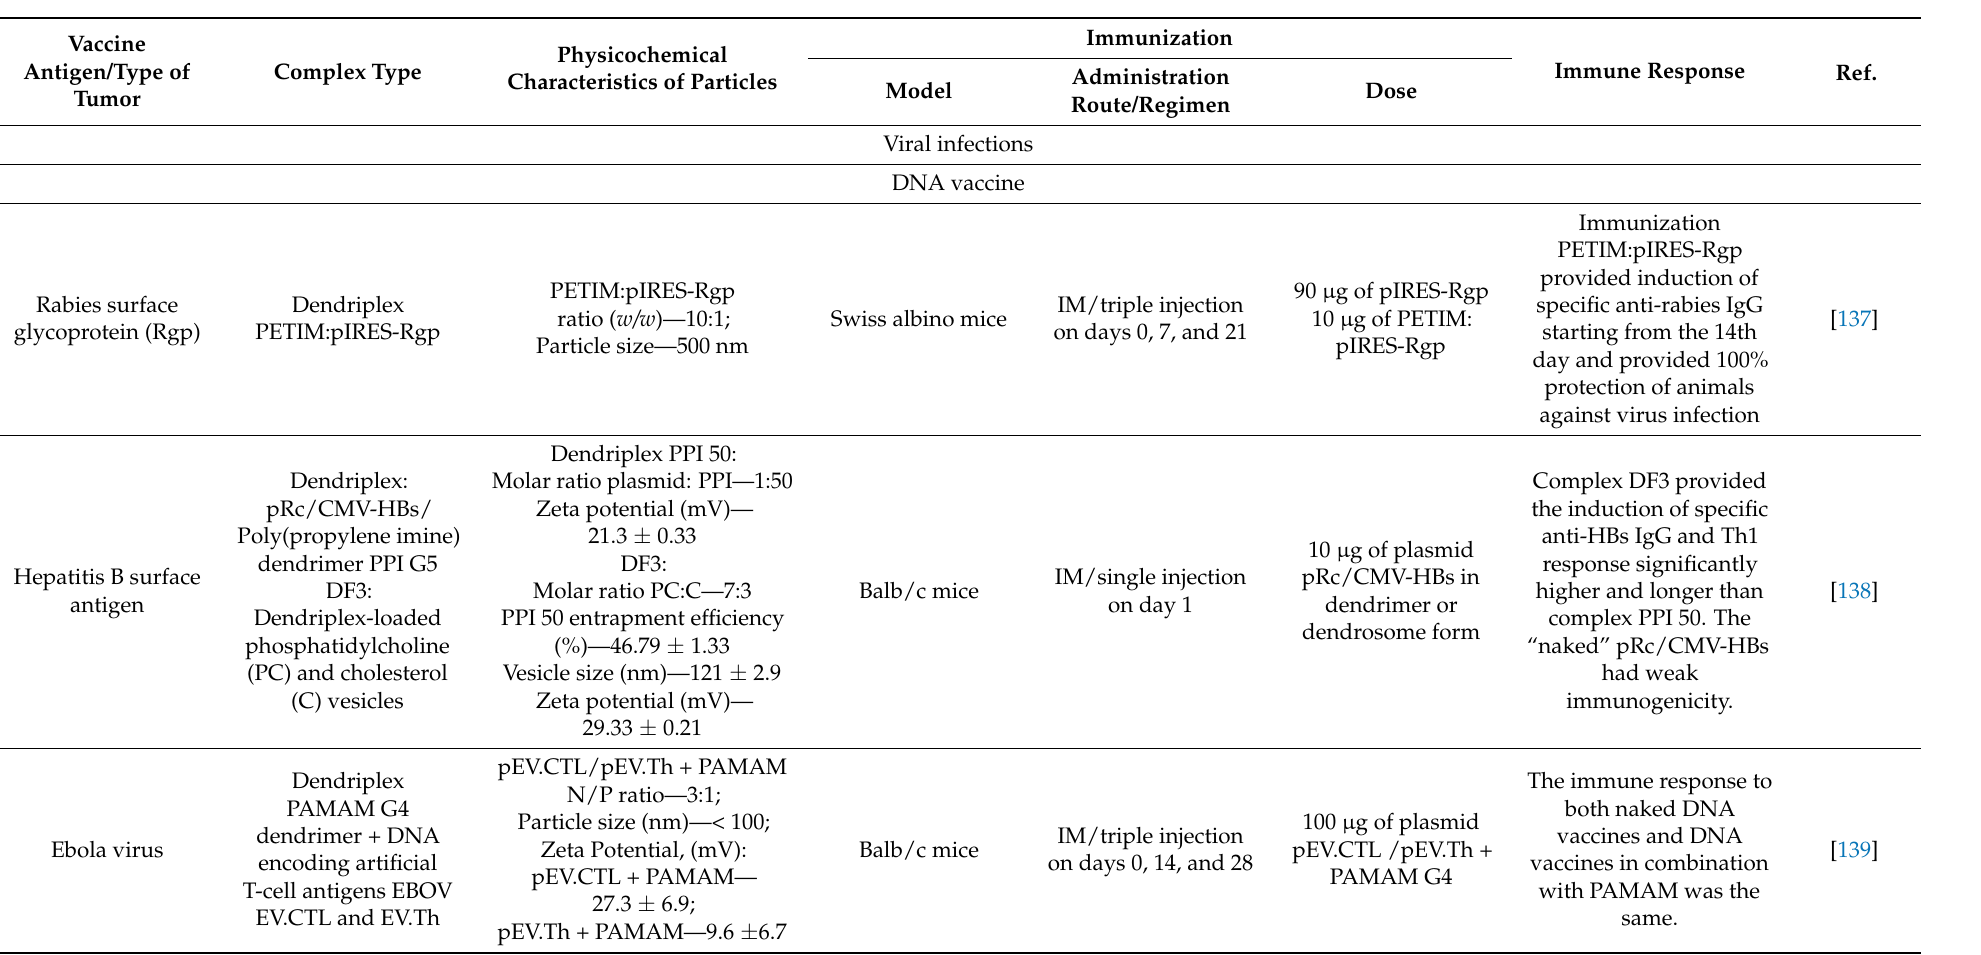
Table 2. Dendrimers for the delivery of DNA and mRNA